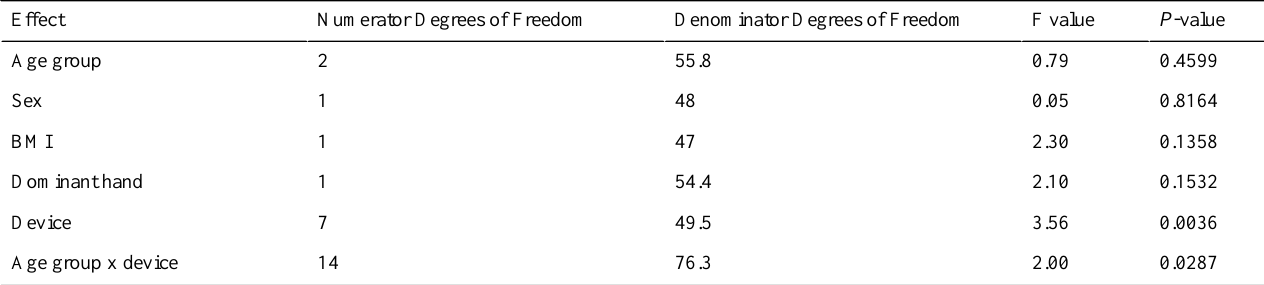
Table 3. Final reduced model type 3 fixed effects.